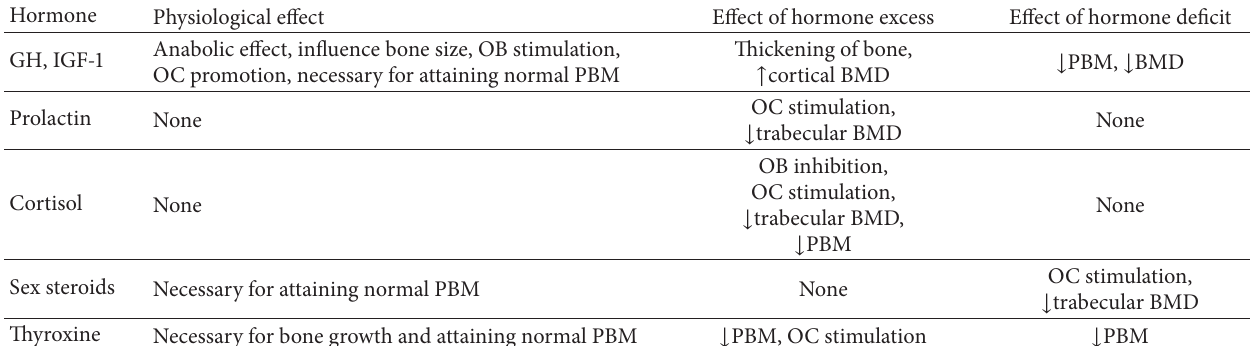
Table 1: Mechanism of bone effects of certain hormones acting in pituitary disorders.